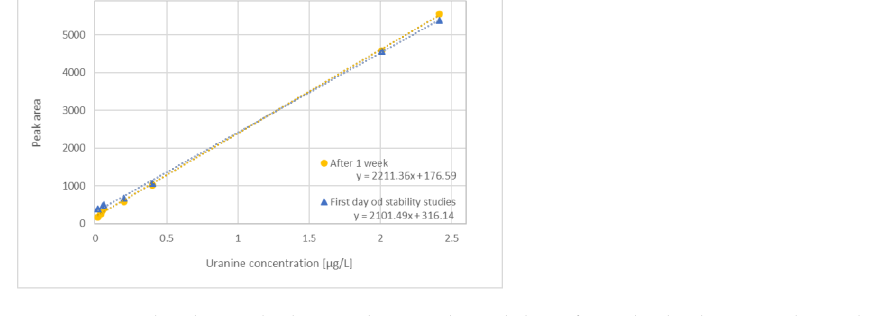
Table 9. Results of measurements and calculations performed to determine the correctness of the method for determining uranine in liquid samples.